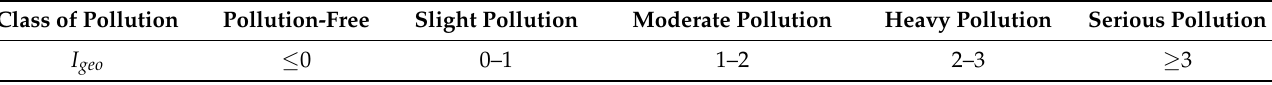
Table 1. Classification standard of sediment accumulation